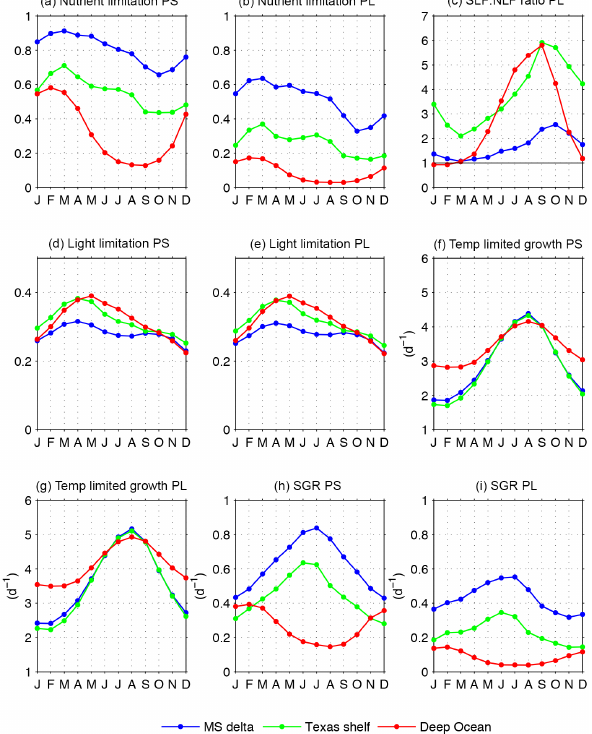
Figure 10. Growth limitation and specific growth rates for nanophy- toplankton (PS) and diatoms (PL): (a, b) nutrient limitation factors; (c) ratio of silica limitation to nitrogen limitation (SLF : NLF; for diatoms only); (d, e) light limitation factors; (f, g) temperature- dependent growth; (h, i) specific growth rates. Factors were aver- aged in the upper 30m layer from the Mississippi delta, Texas shelf, and deep-ocean regions (depicted in Fig. 1, gray